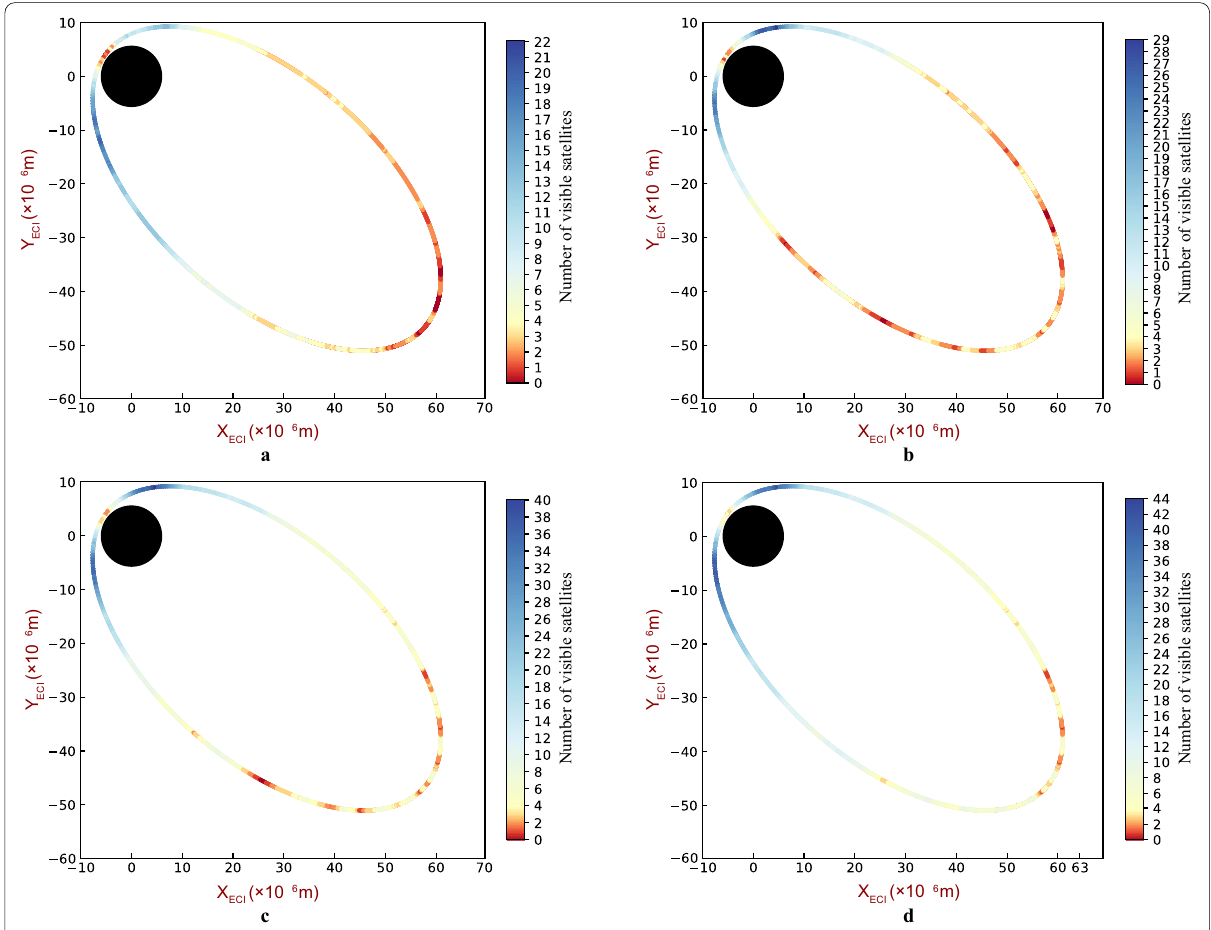
Fig. 4 The number of visible satellites of the spacecraft in SSTO orbit under different combinations: a BDS; b GPS GPS Galileo GLONASS BDS (only MEO satellites); d GPS + + +